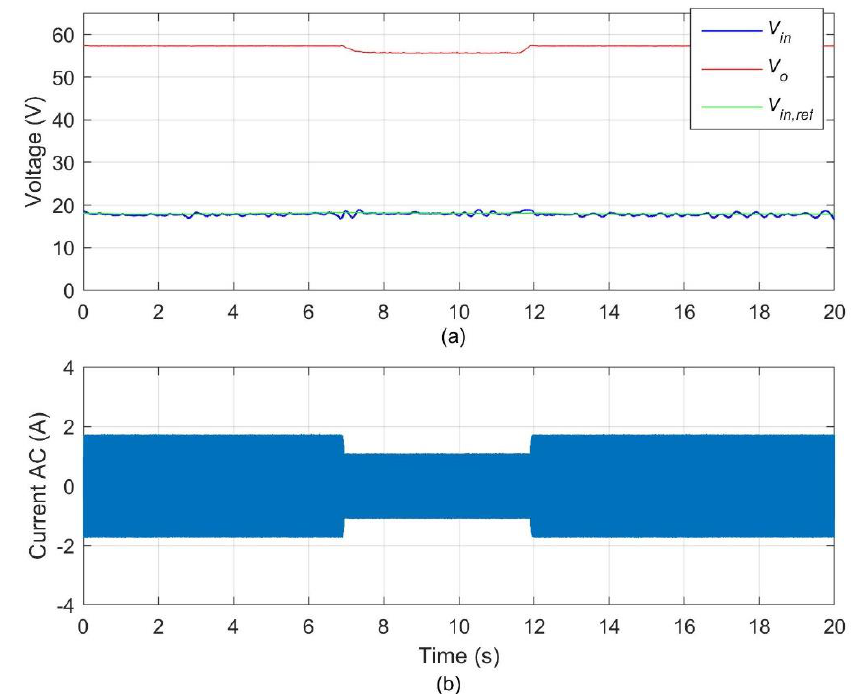
Figure 12. Voltage and current evolution: ( a ) voltage signals at the DC/DC converter and reference voltage; ( b ) AC current.